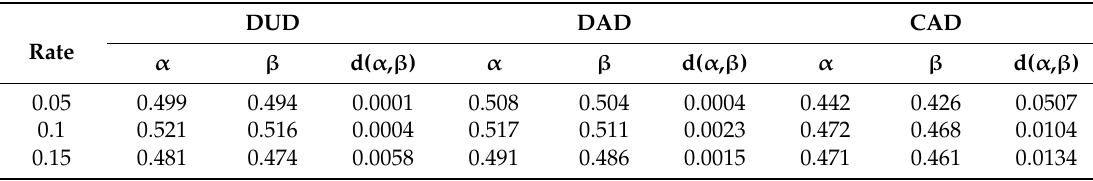
Table 2. d ( α , β ) based on different α and β